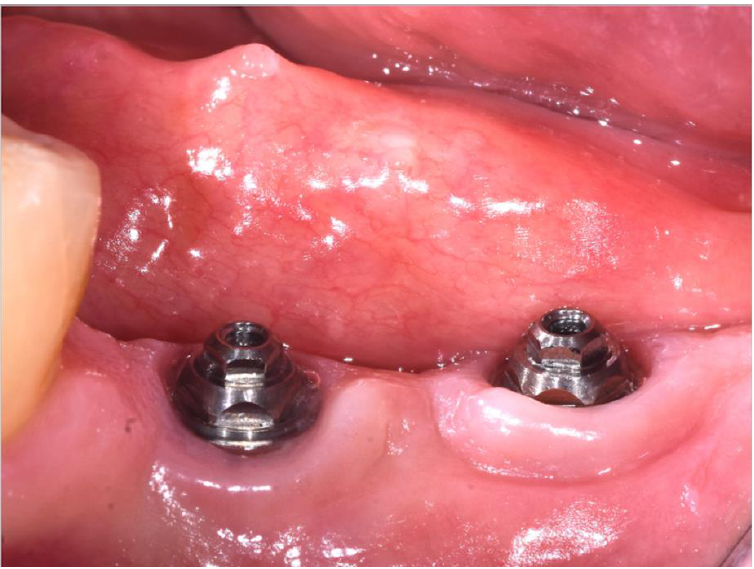
Figure 4. Clinical image showing the healing after 3-month post surgery. Left: machined abutment; Right: super-latex abutment.